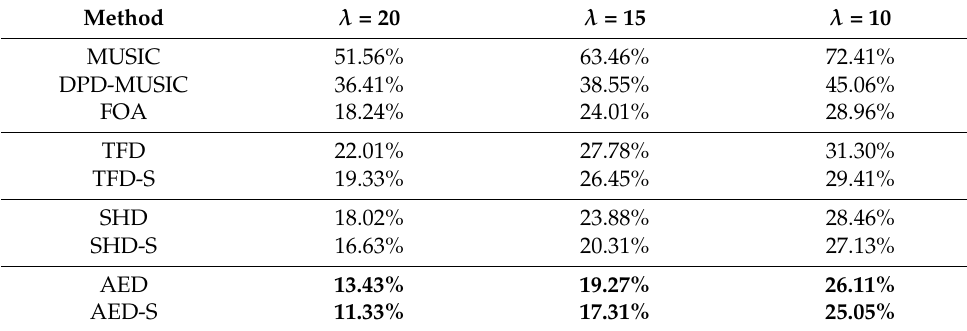
Table 4. GE for the elevation estimation.